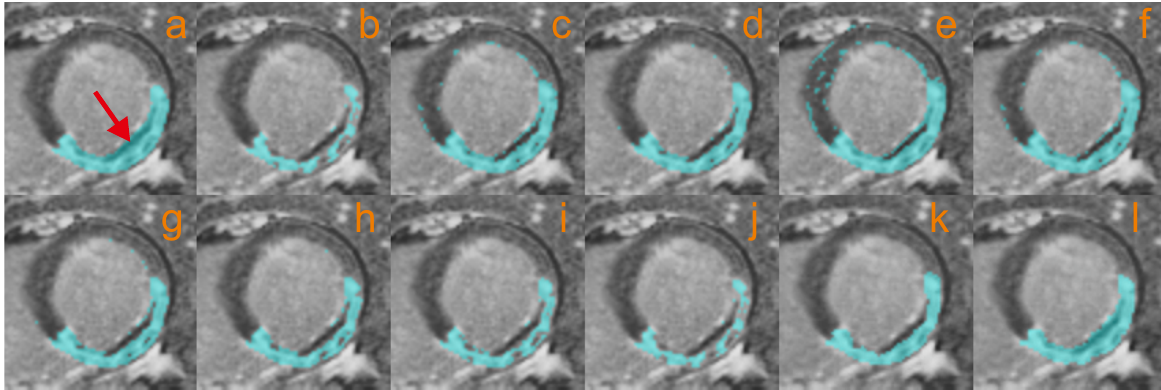
Figure 6. Segmentation results for the microvascular obstruction areas per method. ( a ) Ground-truth. ( b ) Full-width at half-maximum. ( c ) Gaussian mixture model. ( d ) Otsu. ( e ) 1-SD. ( f ) 2-SD. ( g ) 3-SD. ( h ) 4-SD. ( i ) 5-SD. ( j ) 6-SD. ( k ) Proposed coarse segmentation. ( l ) Full proposed method. The arrow indicates the microvascular obstruction